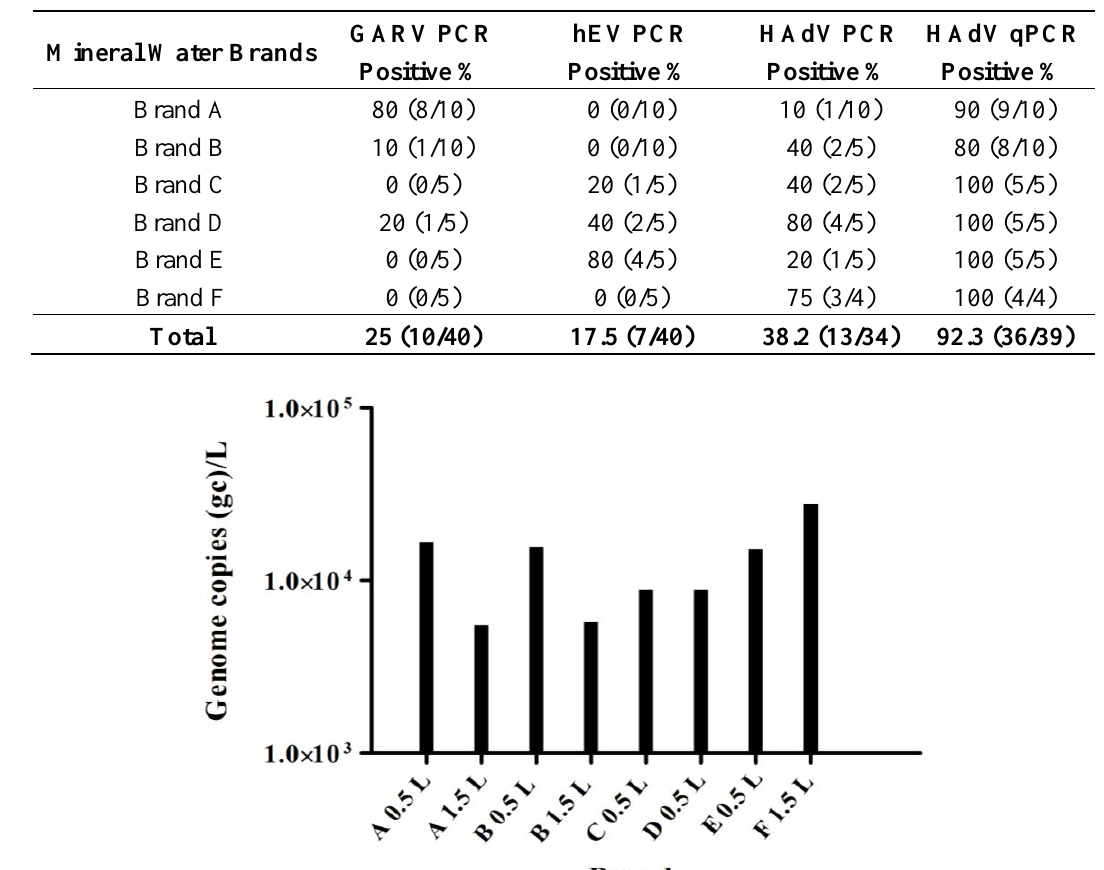
Figure 1. The average HAdV gc/L detected in mineral water samples (in 0.5 L and 1.5 L bottles from the same brand). Values represent the average of four samples of each brand (A–F) and